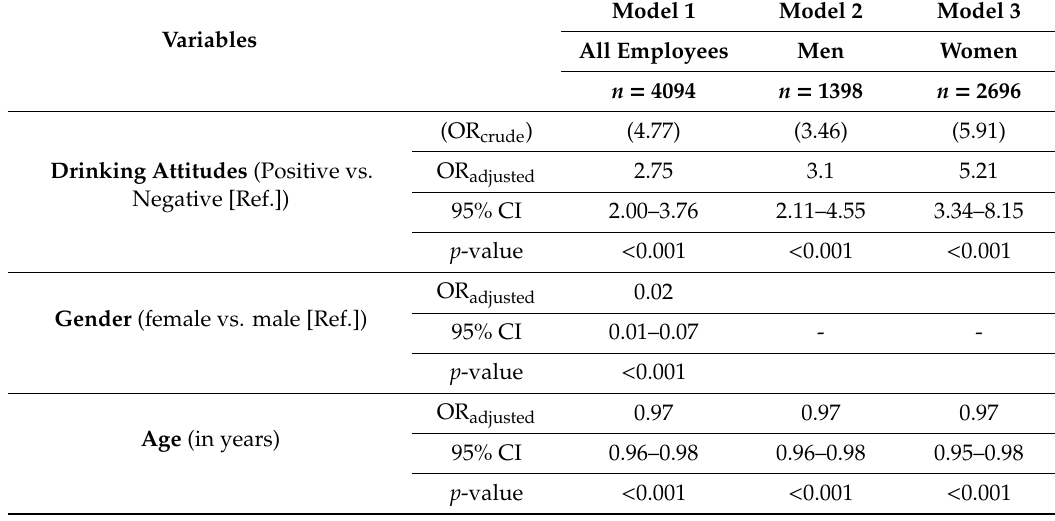
Table 4. Associations (OR and 95% CI) between drinking attitudes and alcohol-related problems, overall (Model 1) and stratified by gender (Models 2 and